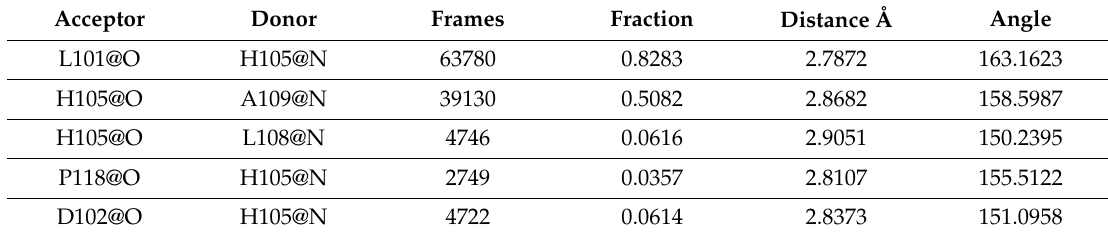
Table 2. Hydrogen bond occupancy of the histidine imidazole ring in the 5c NO-HNOX